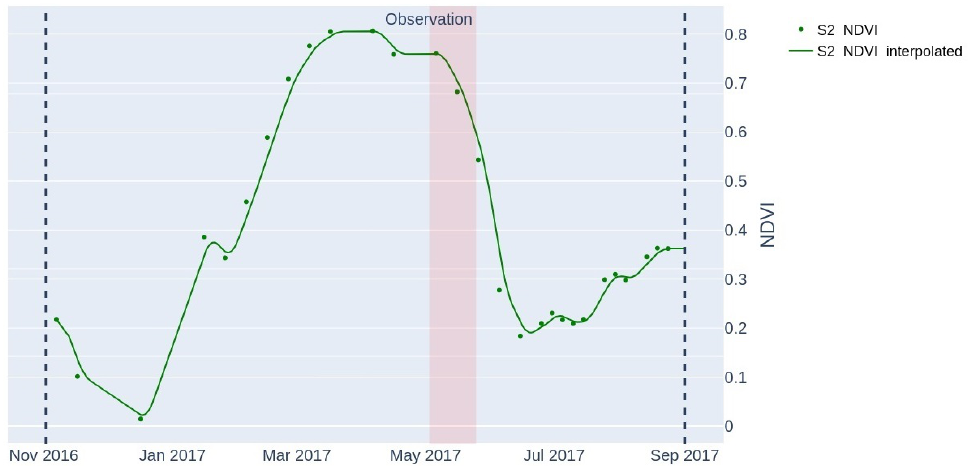
Figure 5. True NDVI points from the Sentinel-2 (S2 NDVI) image source with missing values are interpolated by a moving average (S2 NDVI interpolated). The red-zone in this plot represents the observation of yellow rust disease in the